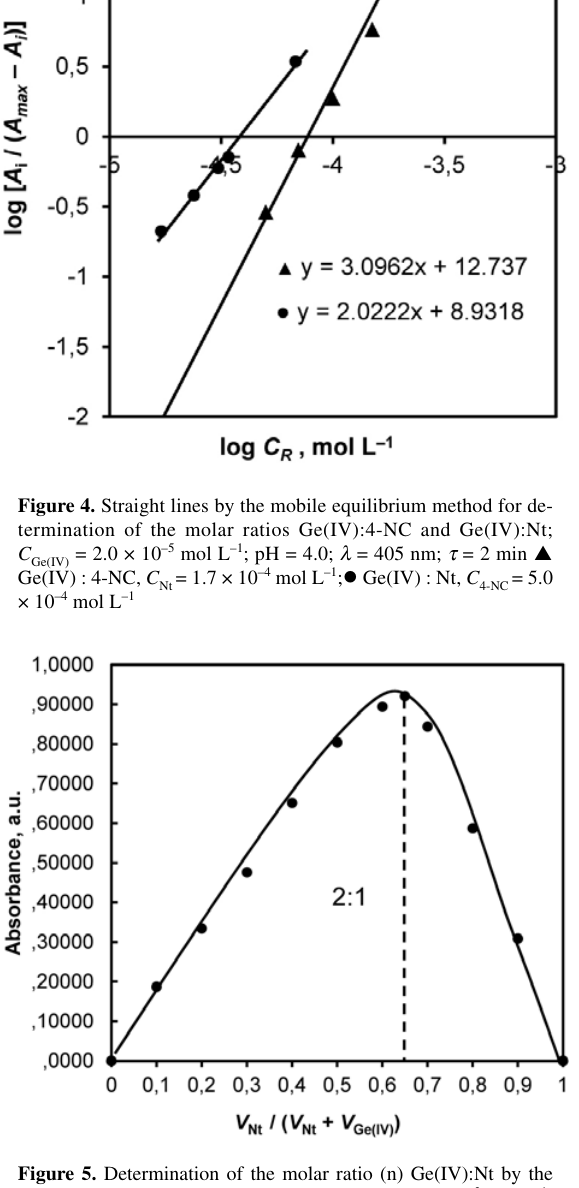
+ C = 1.0 × 10 -3 mol L –1 ; Ge(IV) Nt